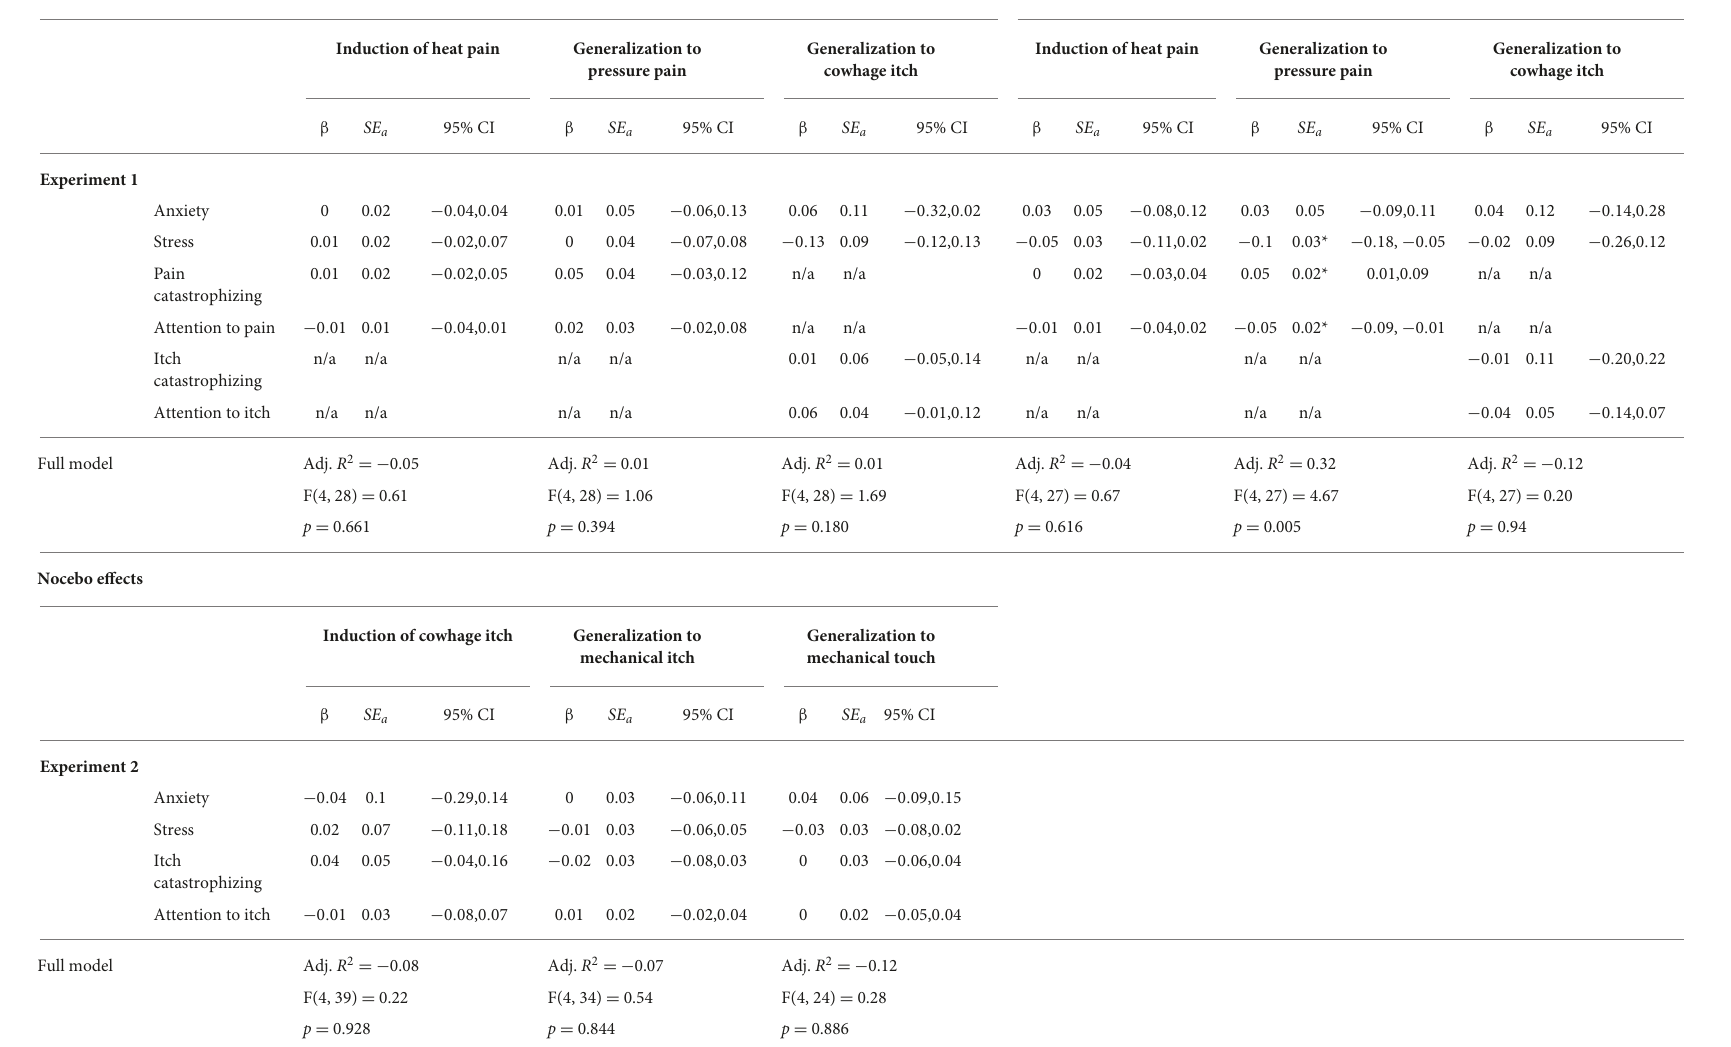
TABLE 3 An overview of multiple regression analyses via forced entry to predict induction of nocebo and placebo effects on heat pain and their generalization to pressure pain and to cowhage-evoked itch in experiment 1 ( n = 33 in the nocebo group, n = 32 in the placebo group), and to predict induction of nocebo effects on cowhage-evoked itch and their generalization to mechanical itch and to mechanical touch in experiment 2 ( n =